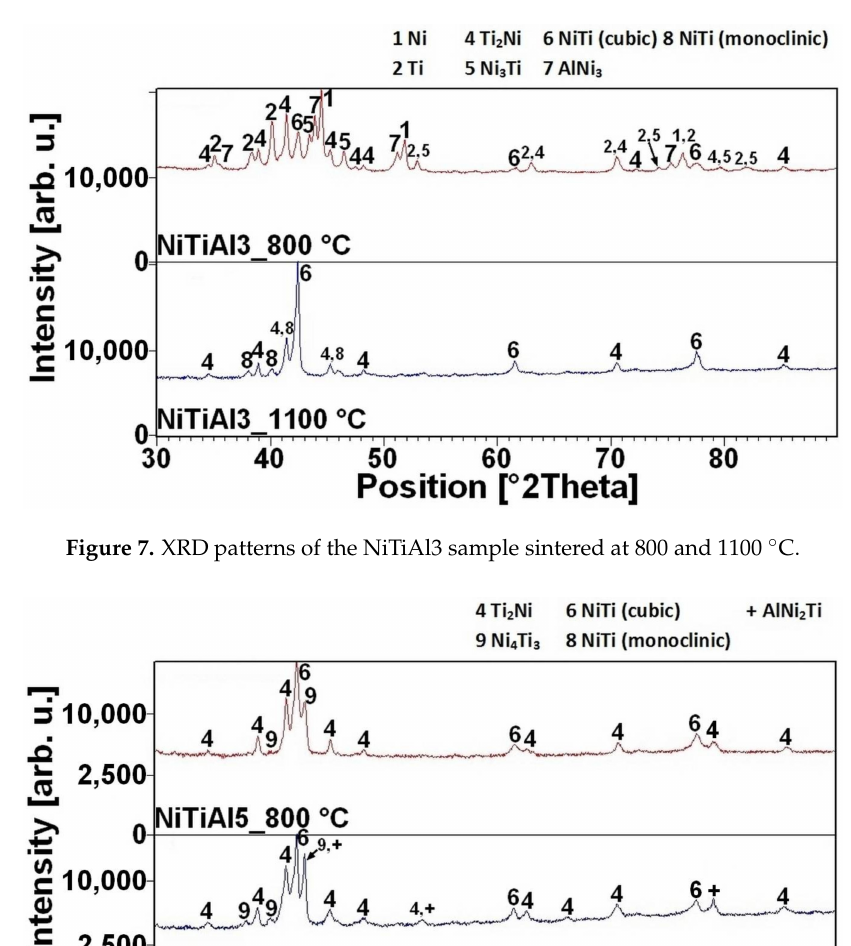
Figure 6. XRD patterns of the NiTiAl1 sample sintered at 800 and 1100 ◦ C.